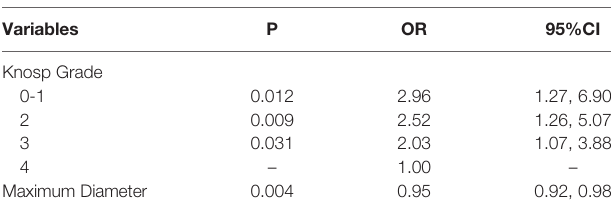
TABLE 8 | Ordinal logistic regression for factors of